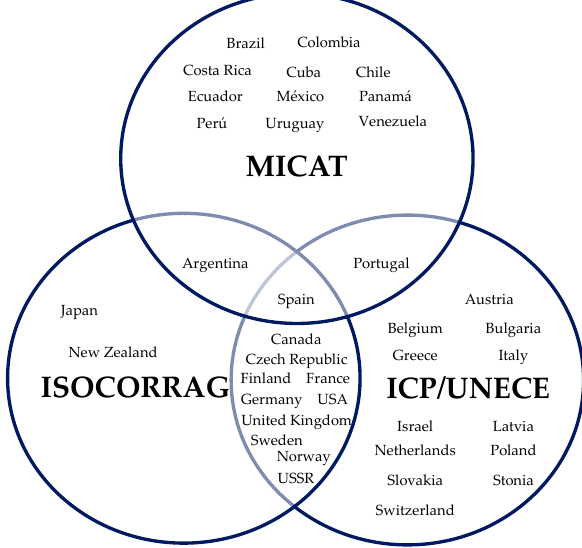
Figure 1. International Collaborative programmes on atmospheric corrosion and participant countries.